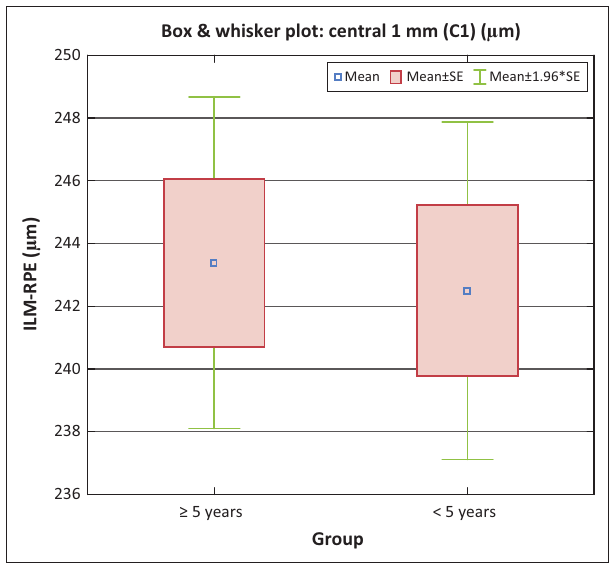
ILM-RPE, internal limiting membrane and retinal pigment epithelium. FIGURE 2: Box and whisker plot of central 1 mm thickness of the ILM and RPE (C1) in Group A and Group B measured with SD-OCT.